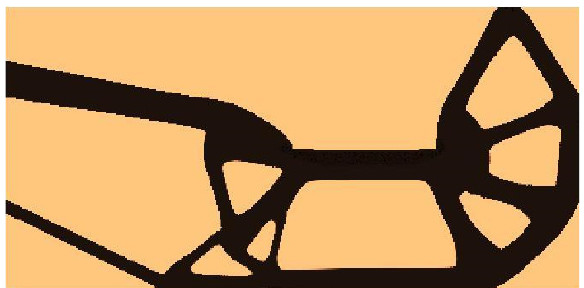
Figure 13. The final topology found for the test structure 2.